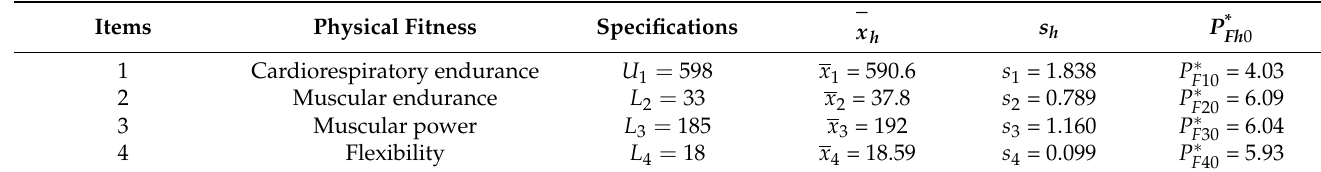
Table 3. Testing statistics and index estimates of the four physical fitness items in the case